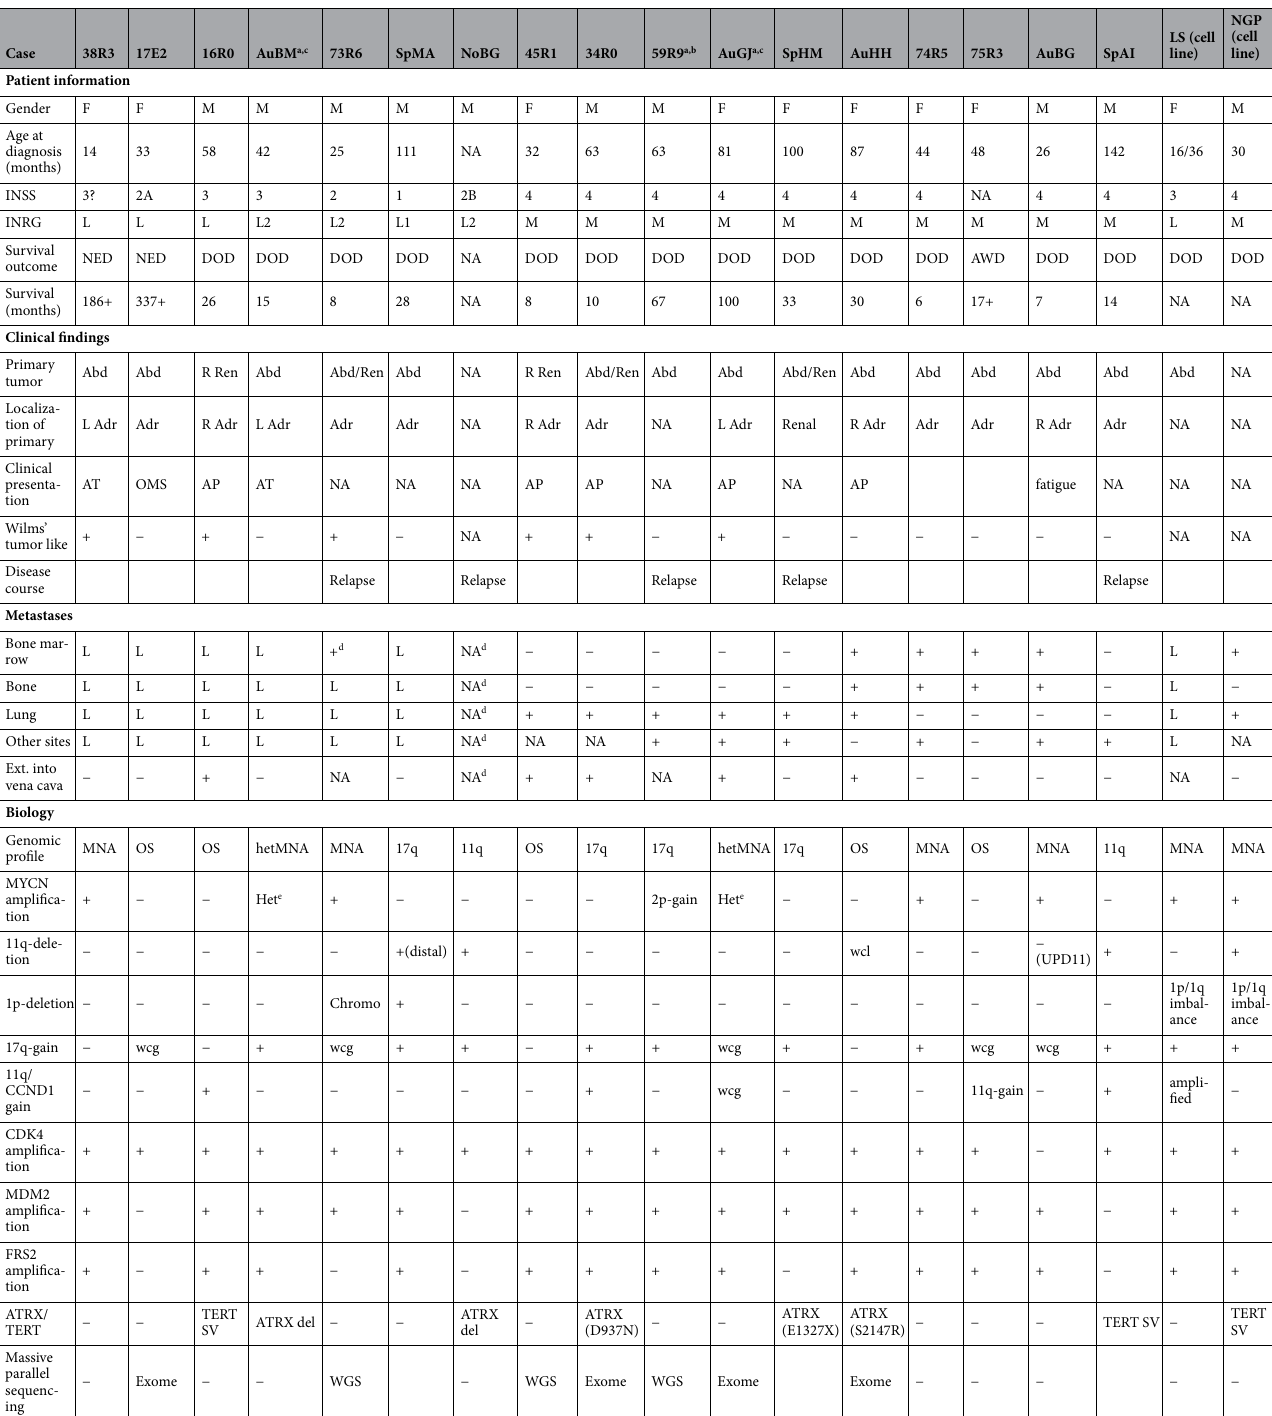
Table 1. Study cohort: biological, genetic, and clinical details. F Female, M Male, L Localized, M Metastasized, INSS International Neuroblastoma Staging System, INRG International Neuroblastoma Risk Group, NED No evidence of disease, AWD Alive with disease, DOD Dead of disease, NA information not available, Abd Abdominal, Adr Adrenal, left (L) or right (R), Ren Renal, AP Abdominal pain, AT Abdominal tumor without pain or other symptoms, OMS Opsoclonus-myoclonus syndrome, MNA MYCN amplification, hetMNA Heterogeneous MYCN amplification, 17q 17q-gain without MNA or 11q-deletion, OS Other structural, Chromo Chromothripsis, wcg Whole-chromosome gain, wcl Whole-chromosome loss, SV Structural variant, del Deletion. a Patients previously described; b Fransson et al., Sci Rep 2020; c Bogen et al., Int J Can 2016; d Initial localized disease, metastatic spreading occurring after two local relapses; e According to